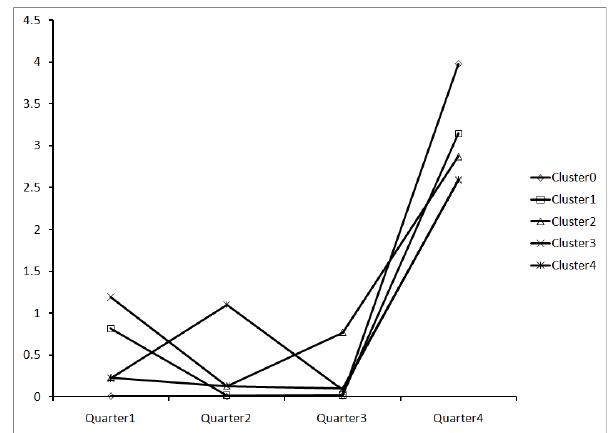
Figure 2. Tier-2 seasonality analysis – 2006 quarterly sales trend of Cluster